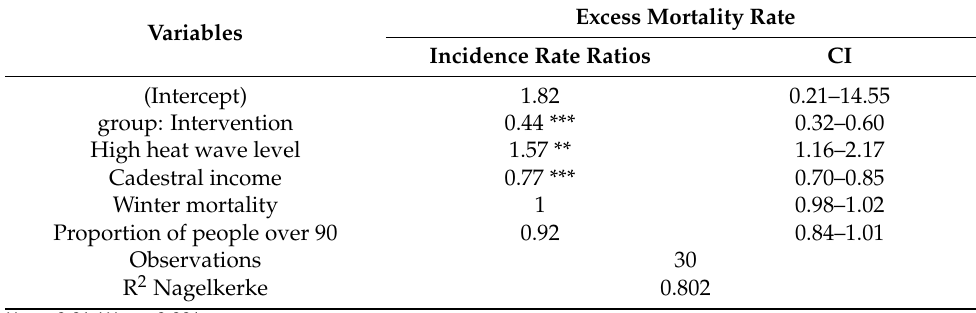
Table 3. Multivariable Poisson